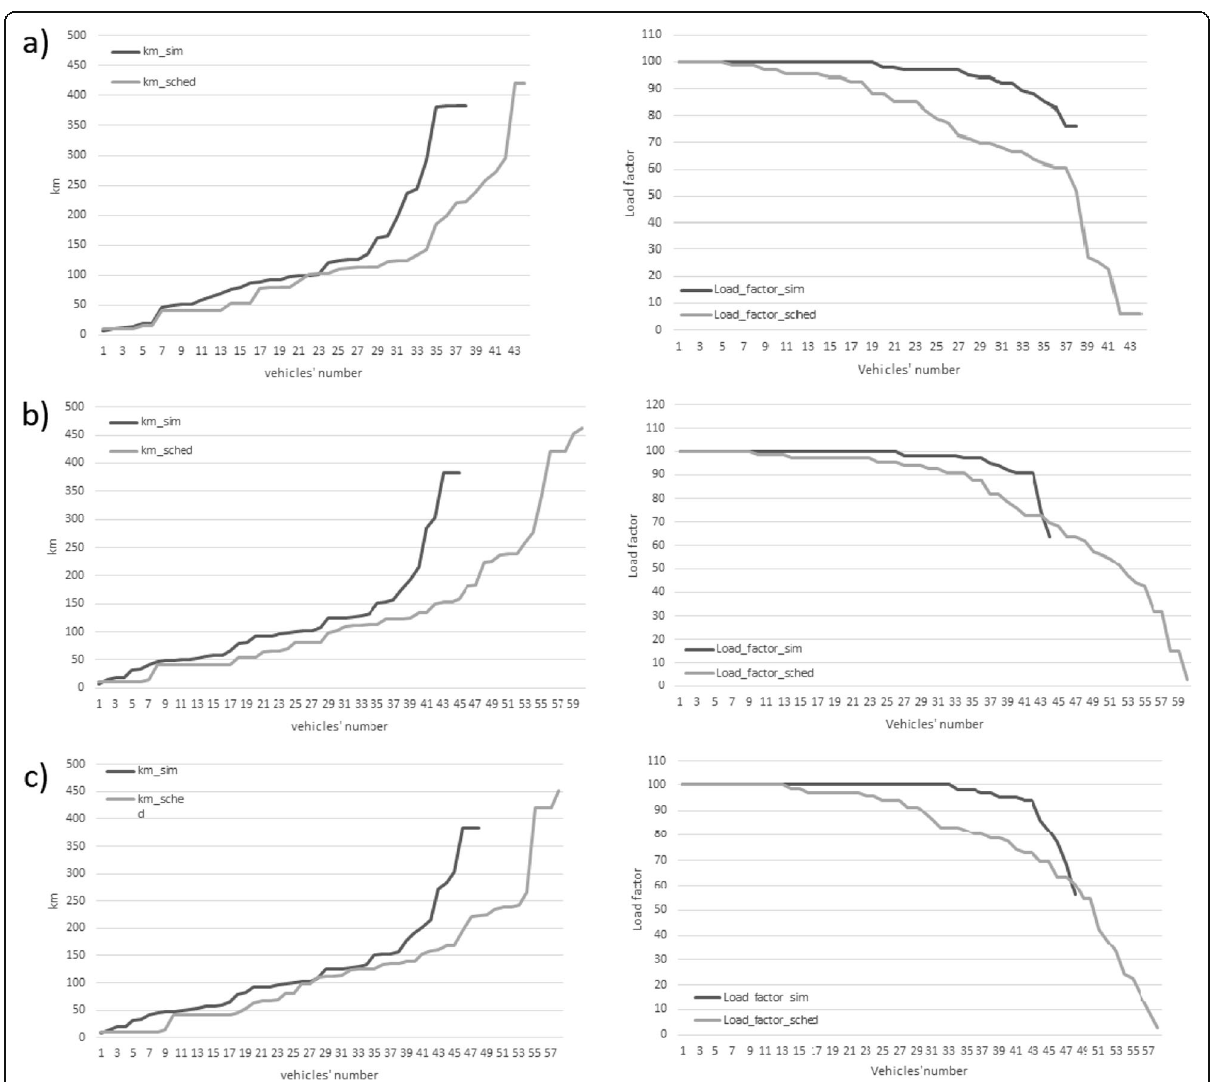
Fig. 6 Scheduled and simulated travelled kilometres and load factors; a first day; b second day; c third